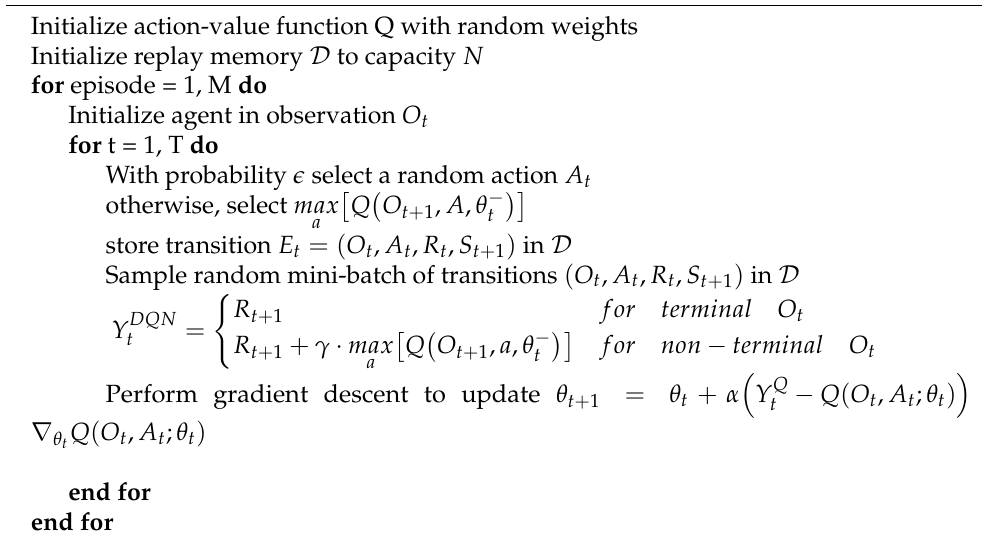
Algorithm 1 DQN with Experience Replay